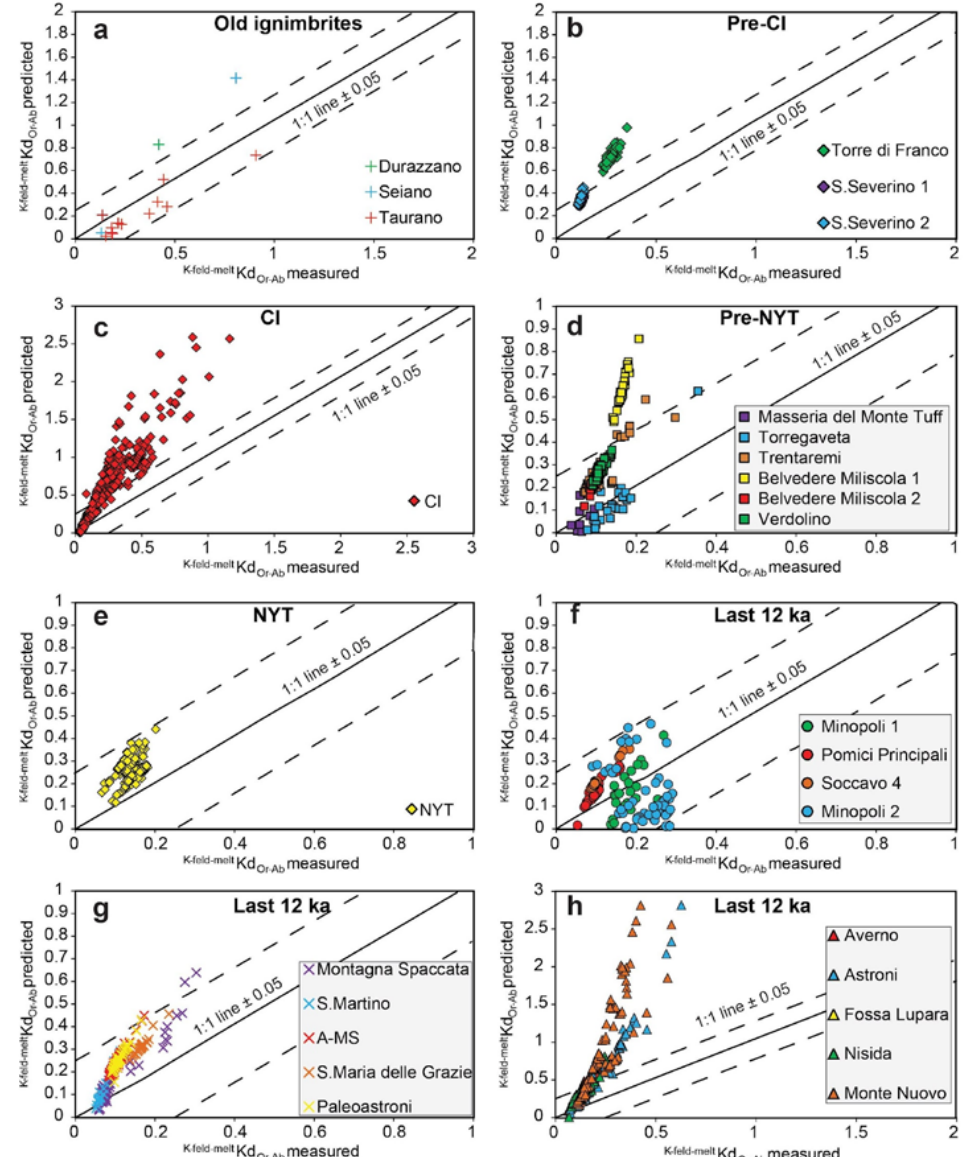
Figure 9. kfeld − liq Kd Or-Ab equilibrium test 3 based on Or-Ab exchange between K-feldspar and liquid [128] for Campi Flegrei feldspars belonging to Old ignimbrites ( a ), Pre-CI ( b ), CI ( c ), Pre-NYT ( d ), NYT ( e ) and last 12 ka ( f – h ); the equilibrium field is inside the 1:1 line ± 0.25.